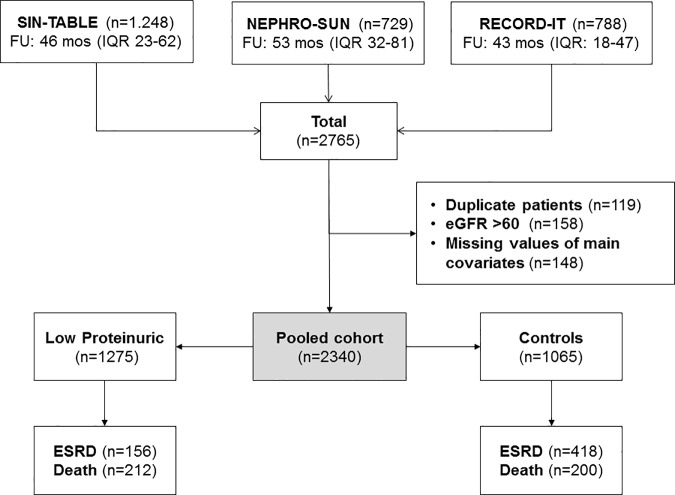
Flow chart of the study.